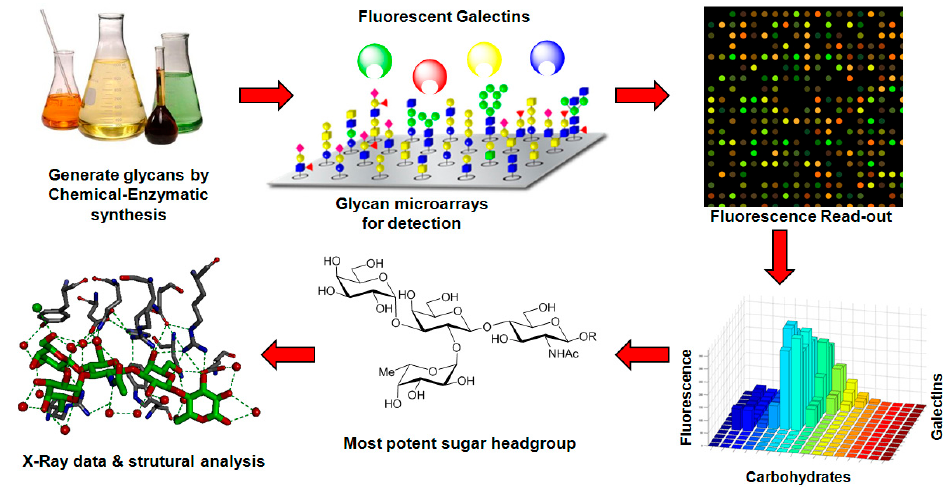
Figure 5. Sequence of steps to identify high-affinity carbohydrate ligands for galectin binding. Galectin interaction with the most potent binders based on this screening can then be studied further on the structural level.